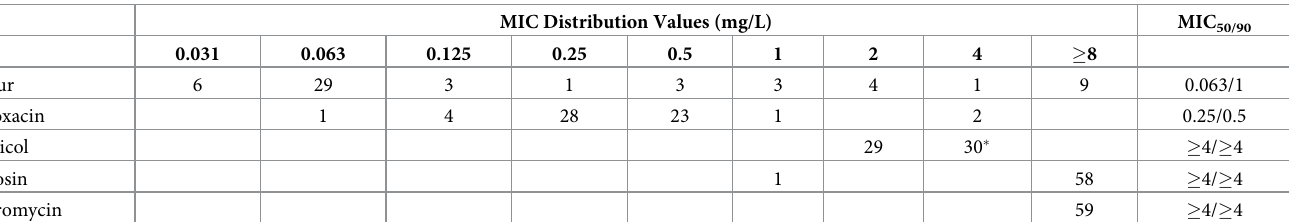
Table 3. Comparative MIC values for 59 S . suis strains collected from